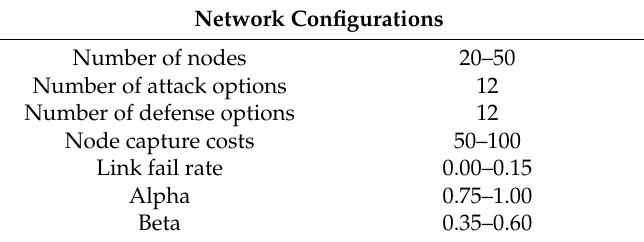
Table 5. Possible Network